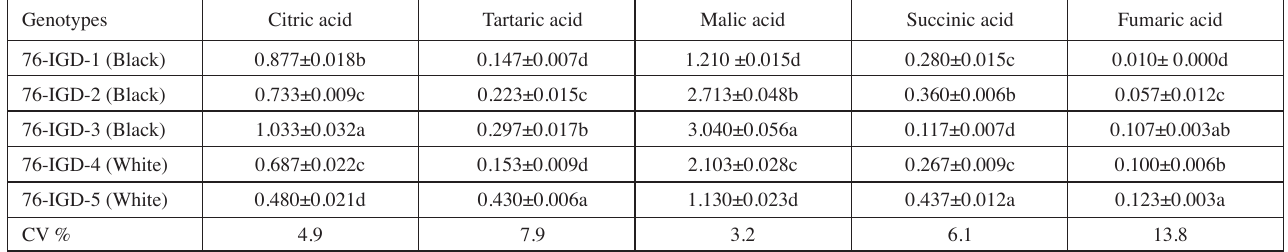
Tab. 1: Organic acids (g/100 g FW) content of black and white mulberry genotypes